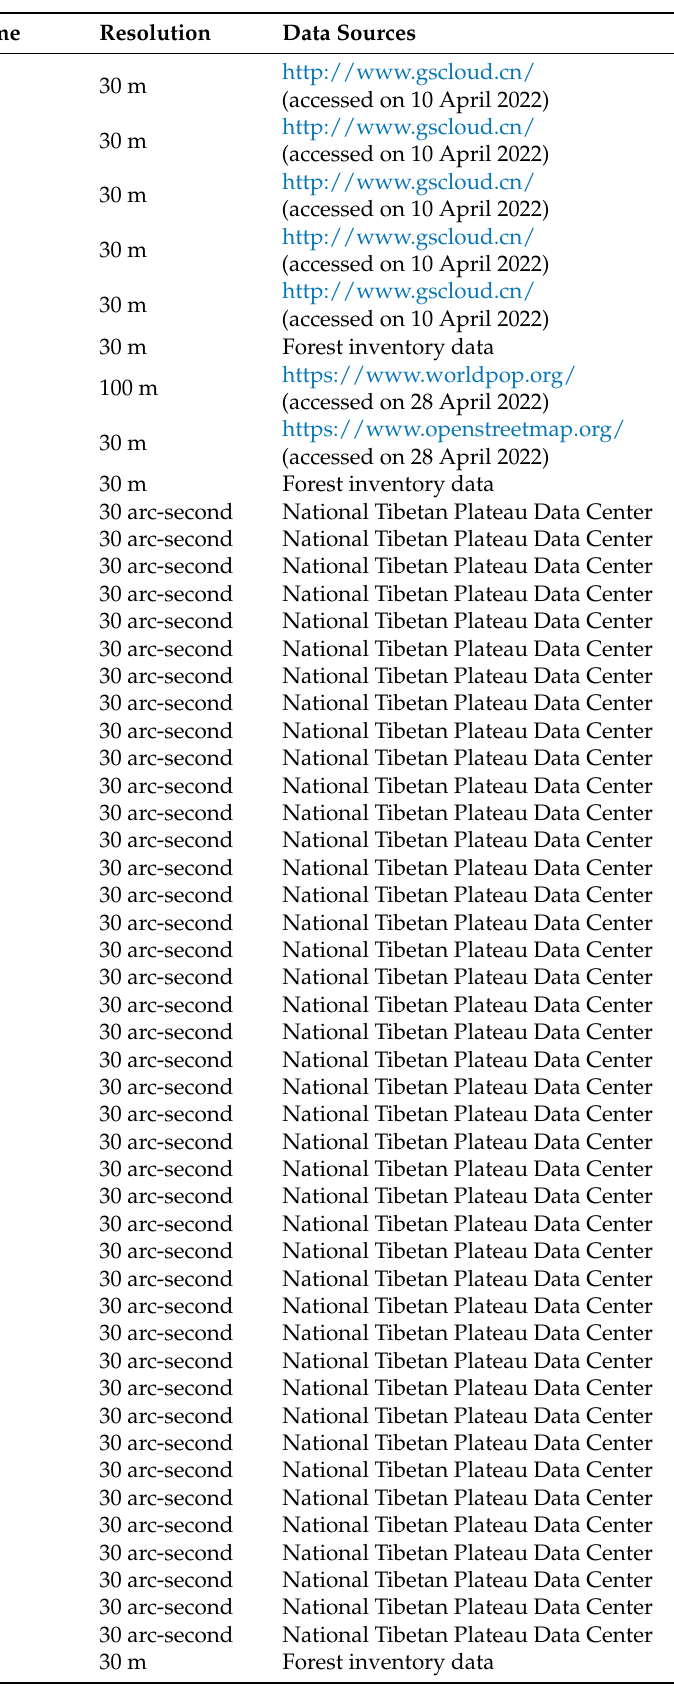
Table 2. List of forest site